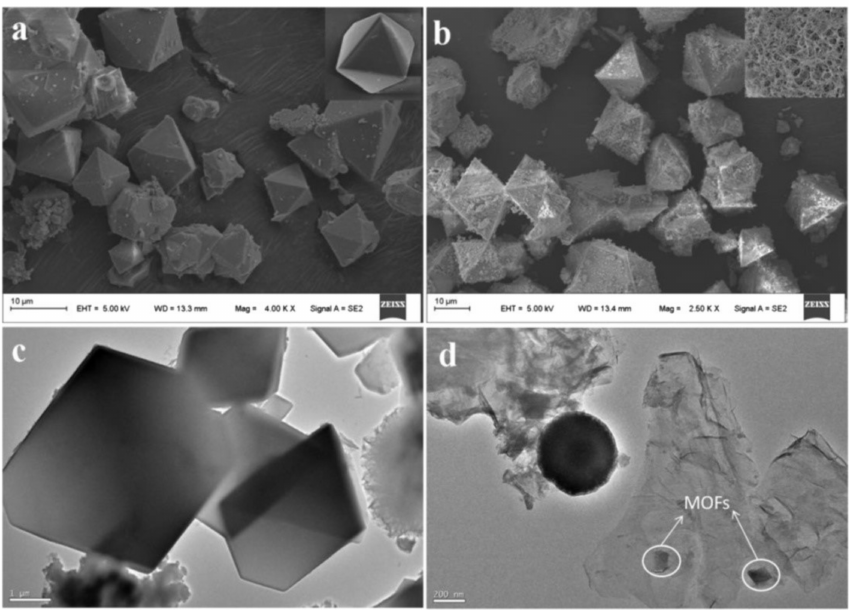
Figure 5. SEM images of Cu-MOFs ( a ) and Fe 3 O 4 @SiO 2 -GO-MOFs ( b ) and TEM images of Cu-MOFs ( c ) and Fe 3 O 4 @SiO 2 -GO-MOFs ( d ). Reproduced with permission from [107]. Copyright Elsevier,